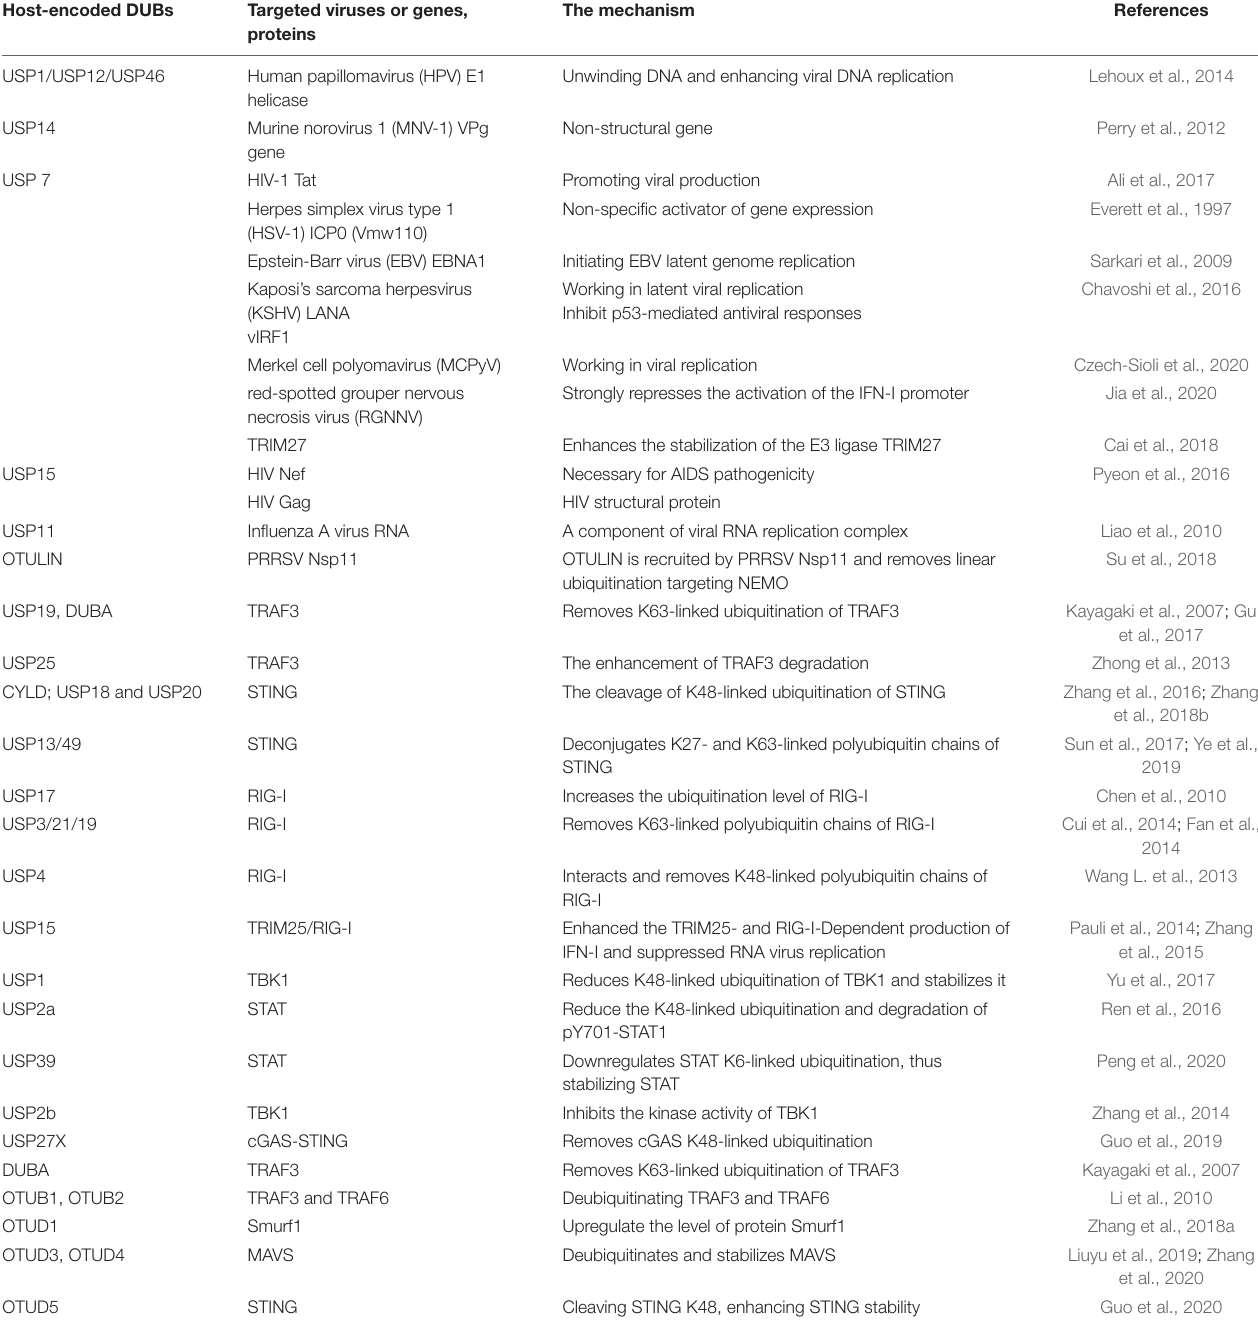
TABLE 1 | Host-encoded DUBs and the targeted viruses, proteins, or